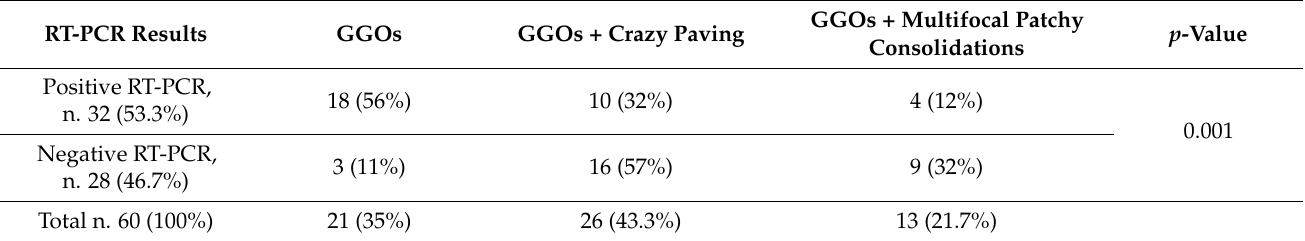
Table 1. Comparison between the reverse transcription-polymerase chain reaction (RT-PCR) results and typical CT findings. GGO: ground-glass opacities.